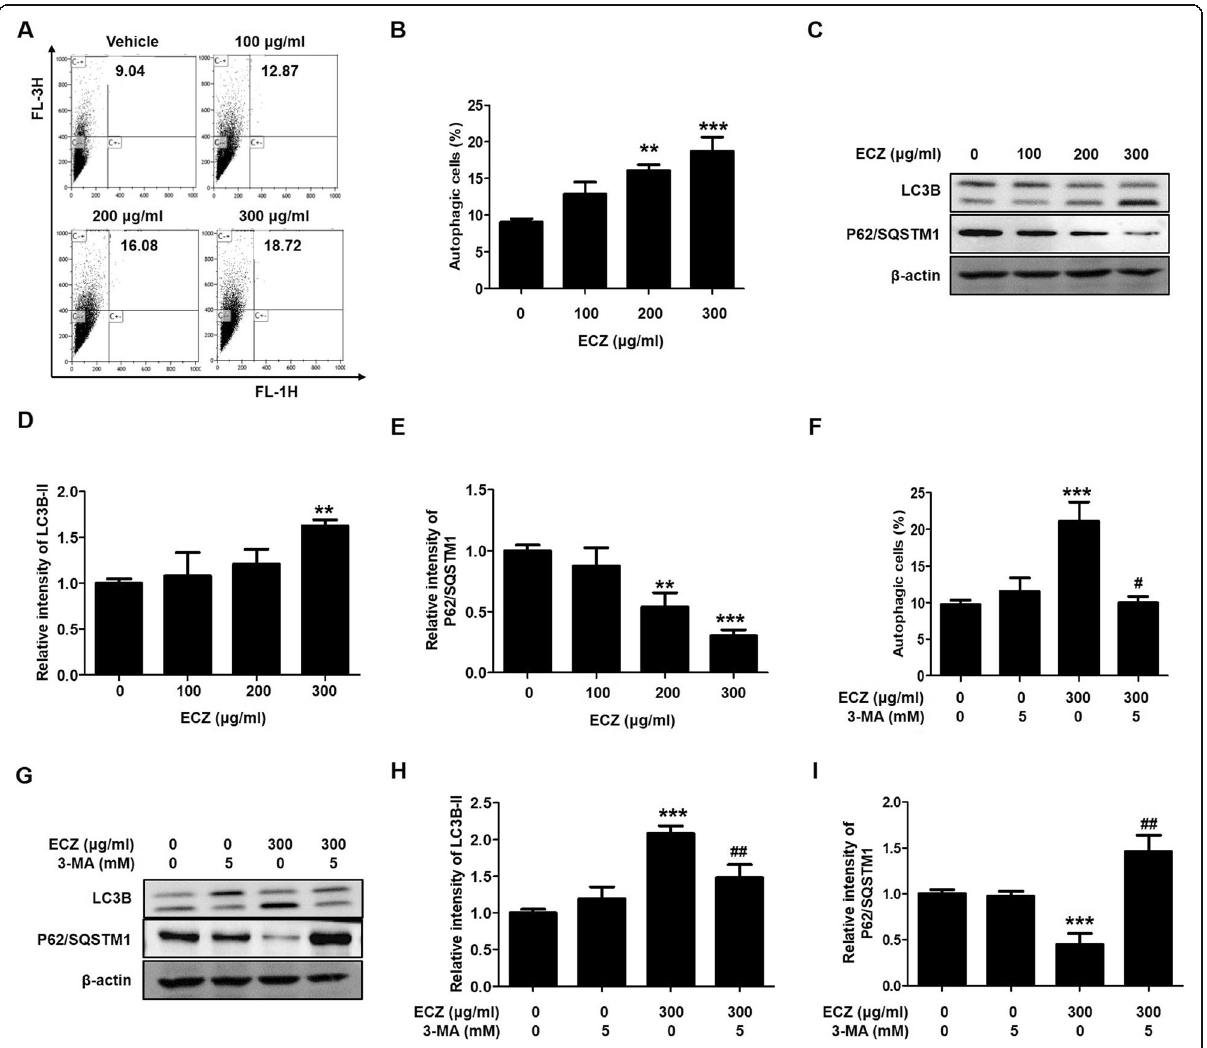
Fig. 3 Ethanol extracts of Chrysanthemum zawadskii Herbich (ECZ) induced autophagy in mouse colon cancer CT-26 cells. a Detection of acidic vesicular organelles (AVOs). b Representive graph of autophagic celss. Cells were treated with various concentrations (100 – 300 μ g/ml) of ECZ for 24 h and stained with 1 μ M acridine orange (AO) at 37 °C in the dark for 20 min and then analyzed by flow cytometry. c Expression of LC3B and p62/SQSTM1. d Relative fold change of LC3B-II. e Relative fold change of p62/SQSTM1. Total cell lysates were analyzed by Western blotting. f Pretreatment with 3-MA reversed the ECZ-induced increase in autophagy. g Effect of 3-MA on LC3B and p62/SQSTM1 expression. h Relative fold change of LC3B-II. (I) Relative fold change of p62/SQSTM1. Cells were pretreated with 1 mM 3-MA prior to 1 h and AO-stained cells were evaluated by flow cytometry. Total lysates were subjected to SDS-PAGE for Western blot analysis. Data are presented as the mean ± standard deviation for at least three independent experiments. ** p < 0.01, *** p < 0.001 vs. the control group; # p < 0.05, ## p < 0.01 vs. the ECZ treated